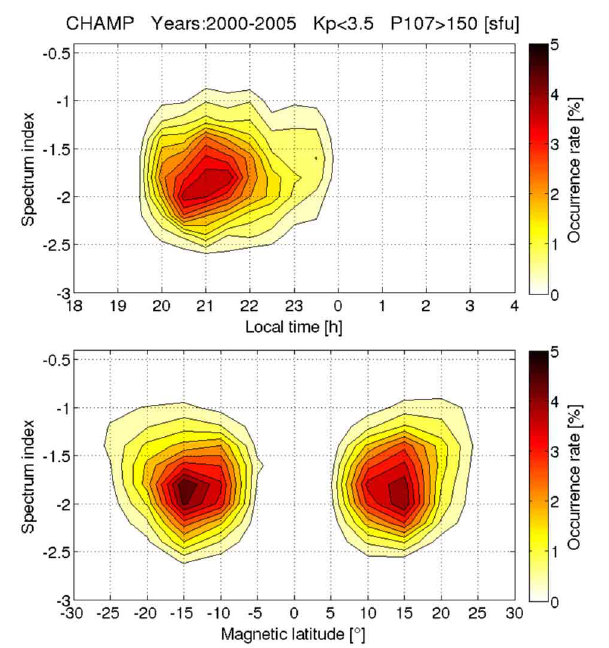
FIGURE 8 | Properties of the intermediate-scale spectral indices. The top frame shows the dependence of the index on local time, and at the bottom the variation with magnetic latitude is